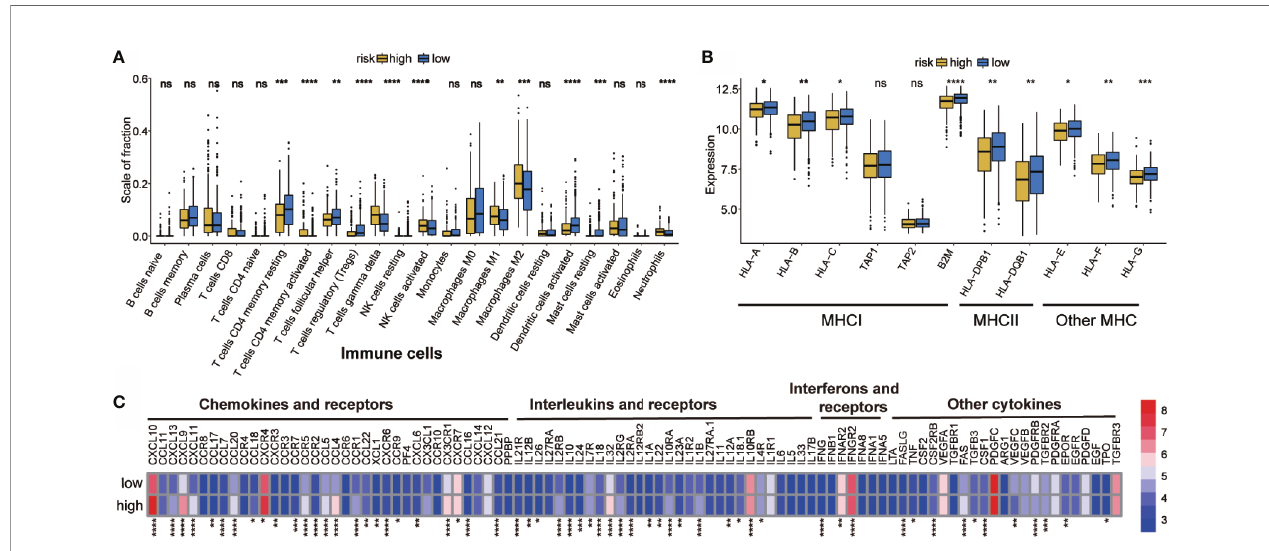
FIGURE 4 | Potential intrinsic immune escapemechanismsof ovarian cancer. (A) Abundance ofeach TME in fi ltratingcellinhigh- andlow-riskgroups. (B) Expression of MHC inhigh- and low-riskgroups. (C) Differential mRNA expression of chemokines, ILs, IFNs, and other important cytokines and their receptors inhigh- and low-risk groups (categorizedby the median value).The upper andlower ends of the boxes represent the interquartile range ofvalues. The lines inthe boxes represent the median value, and the black dots show the outliers. * p < 0.05, ** p < 0.01, *** p < 0.001, ns, p < 0.05, ****P <